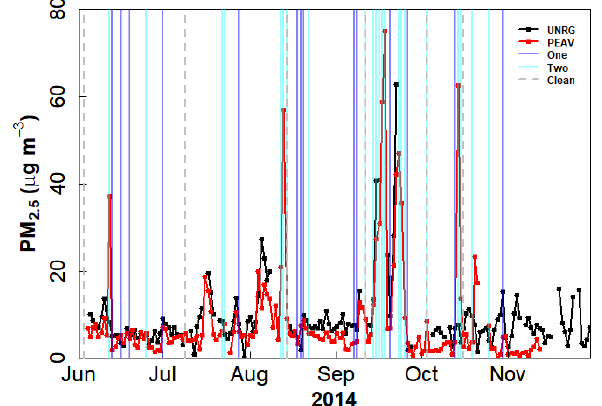
Figure 2. PM 2 . 5 (µgm − 3 ) at PEAV (red) and UNRG (black) for June to November 2014. Vertical dark blue lines are days with ag- gregates on one inlet, vertical light blue lines are days with aggre- gates on two inlets, and dashed grey lines are days when the inlets were